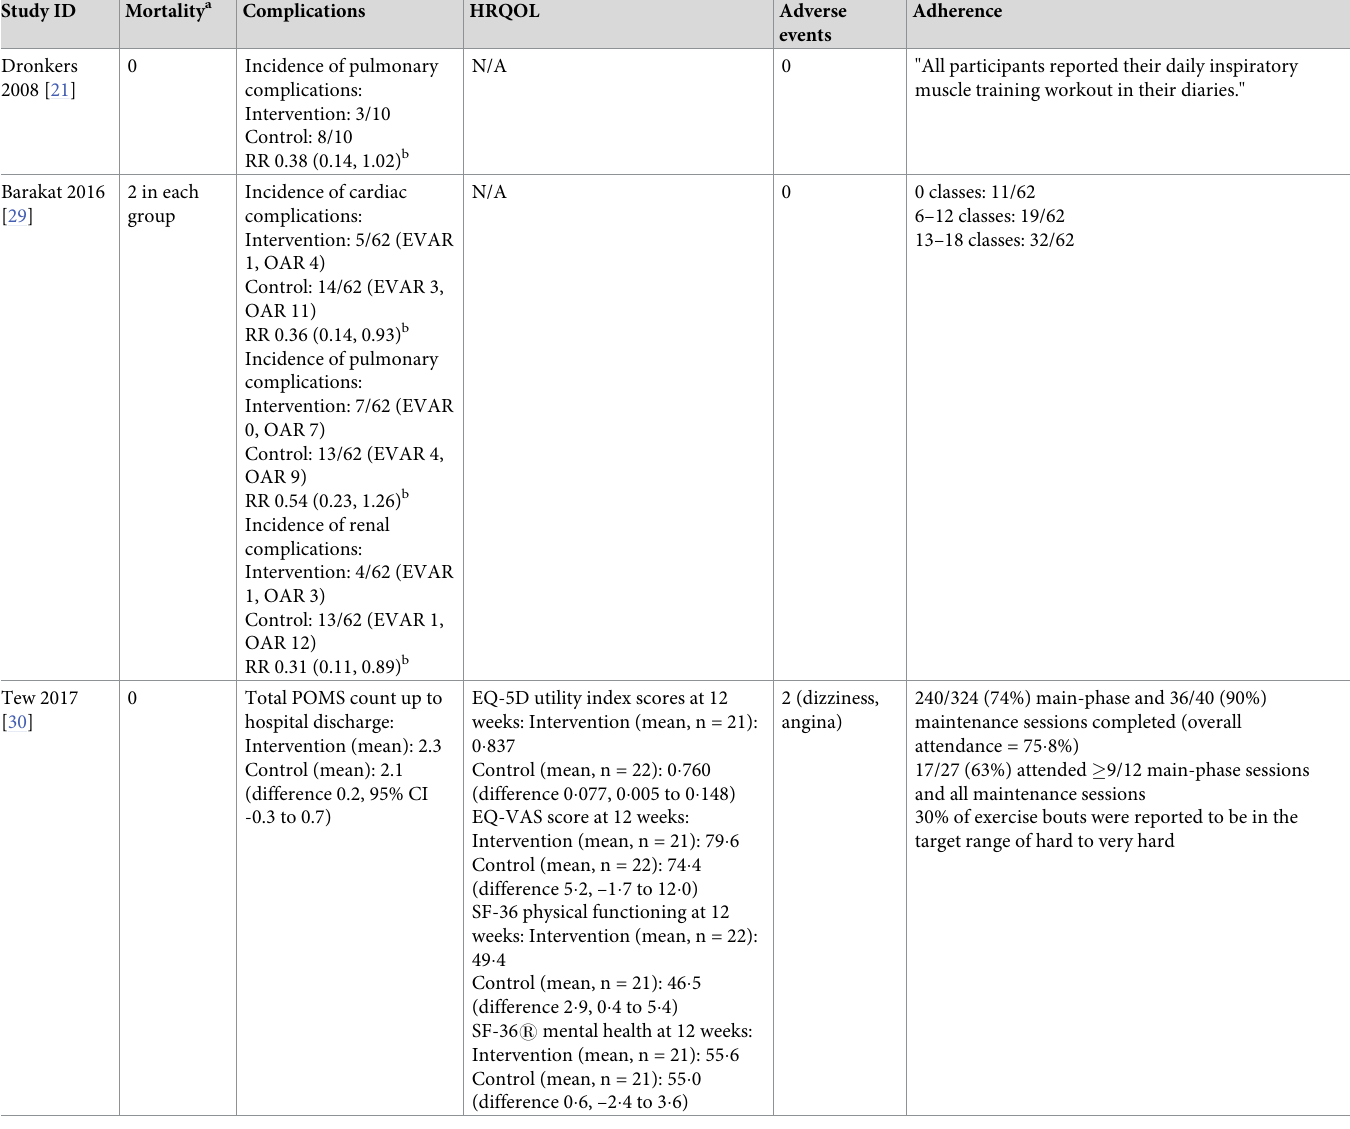
Table 3. Outcome